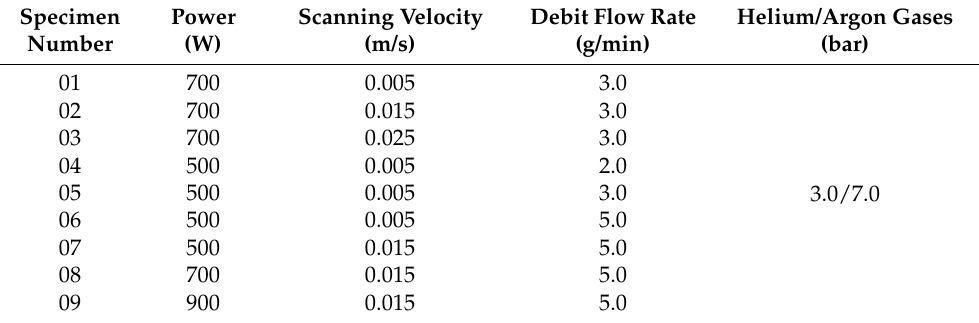
Table 1. Ti6Al4V single layer depositions using LMD set-up.